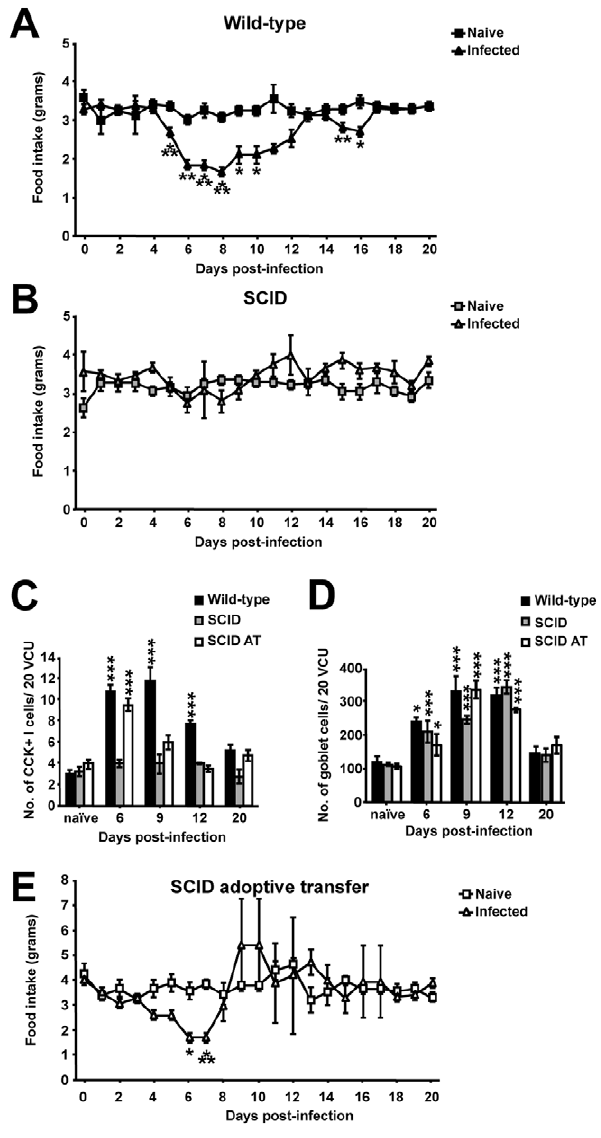
Figure 2. Adoptive transfer of CD4 + T-cells to SCID mice restores hypophagia during enteritis. Food intake of naı¨ve and infected wild-type ( A ), SCID ( B ) and adoptively transferred SCID mice ( E ), derived via weighing chow daily. Number of CCK positive I-cells in wild- type, SCID and adoptively transferred SCID mice ( C ) and number of goblet cells in wild-type SCID and adoptively transferred SCID mice ( D ); cells/20 VCU accessed via immunohistochemistry and periodic acid- Schiff’s histology staining respectively. Data (n=4 mice per group) from 2 independent experiments. *, P , 0.05; **, P , 0.01; or ***, P , 0.005 between naı¨ve and infected groups, error bars represent SE of